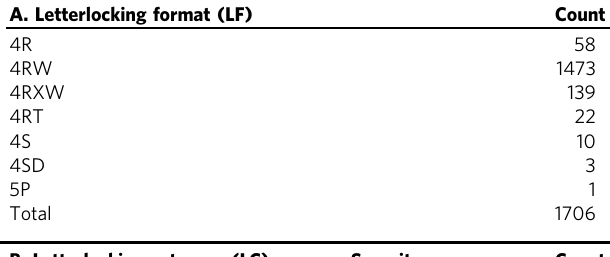
Table 2 Breakdown of Brienne Collection by letterlocking format (A) and category (B and